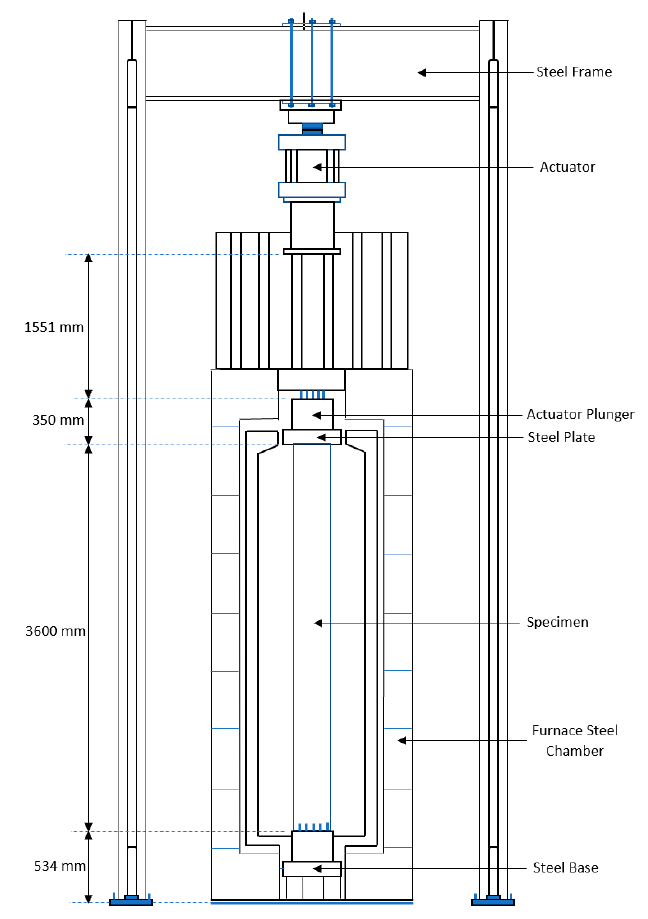
Figure 4. Thermocouple attachment along the column. Table 1. Thermocouple notation on the column.